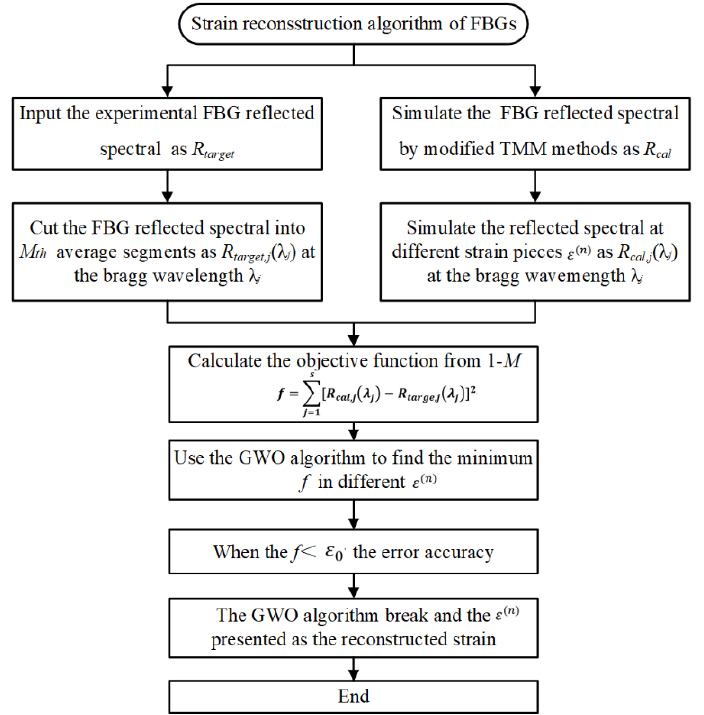
Figure 2. Flow chart of strain reconstruction algorithm of FBGs.